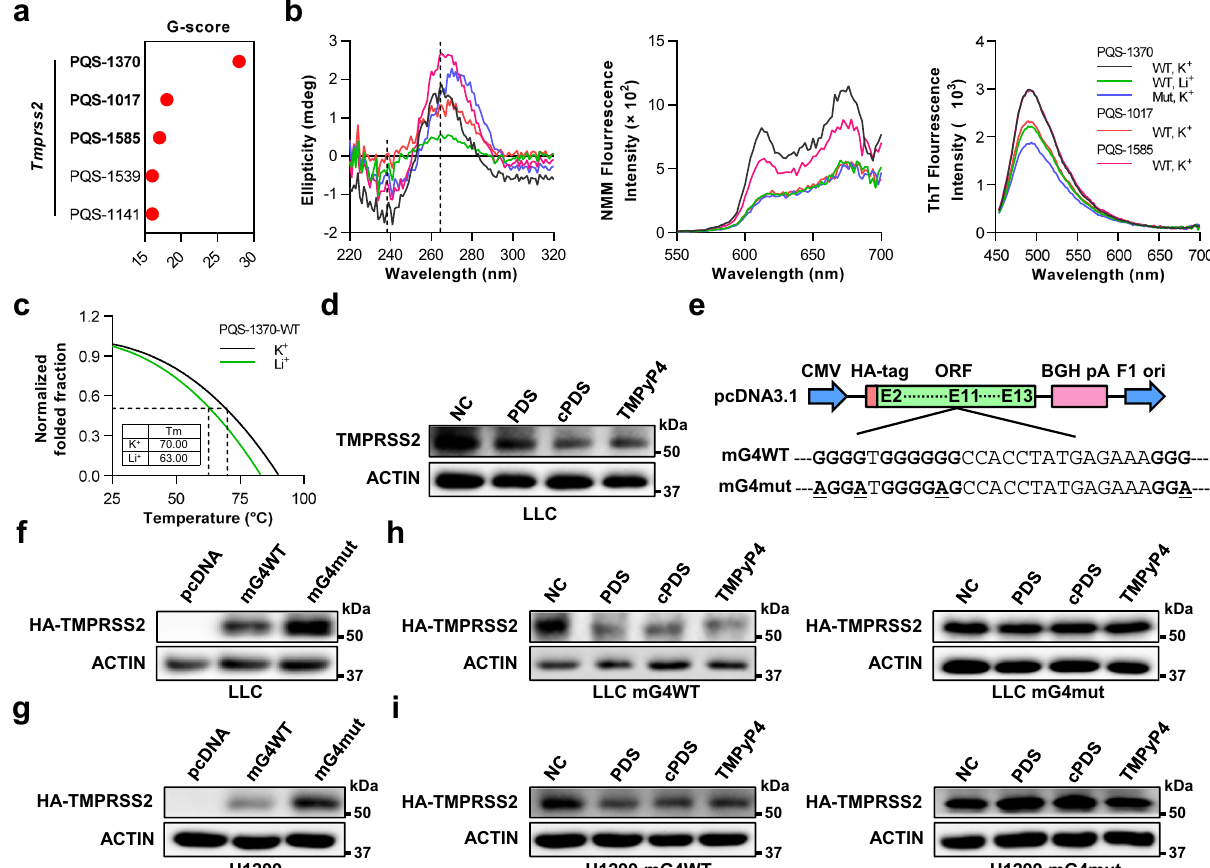
Fig. 4 RG4 in murine Tmprss2 mRNA inhibits its protein expression. a RG4 potential of mouse Tmprss2 mRNA was predicted by QGRS-Mapper. b CD spectrum (left panel), NMM (middle panel), and ThT (right panel) fl uorescence emission spectra of PQS-1017, PQS-1370, and PQS-1585 RNA under KCl or LiCl conditions. c CD-melting measurements of PQS-1370-WT RNA under KCl or LiCl conditions. d Levels of endogenous TMPRSS2 protein in LLC cells treated with PDS (10 μ M), cPDS (10 μ M), or TMPyP4 (10 μ M). e The full-length ORF region of murine Tmprss2 or its RG4-mutant sequence was inserted into the MCS of pcDNA3.1 vector. The bold letters represent the G-tracts and the underlined letters represent mutations. f , g Levels of HA-TMPRSS2 protein in LLC ( f ) and H1299 ( g ) cells transfected with mG4WT or mG4mut plasmids. h , i Levels of HA-TMPRSS2 protein in LLC ( h ) and H1299 ( i ) cells transfected with mG4WT (left panel) or mG4mut (right panel) plasmids, and stimulated with PDS (10 μ M), cPDS (10 μ M), or TMPyP4 (10 μ M). Source data are provided as a source data fi